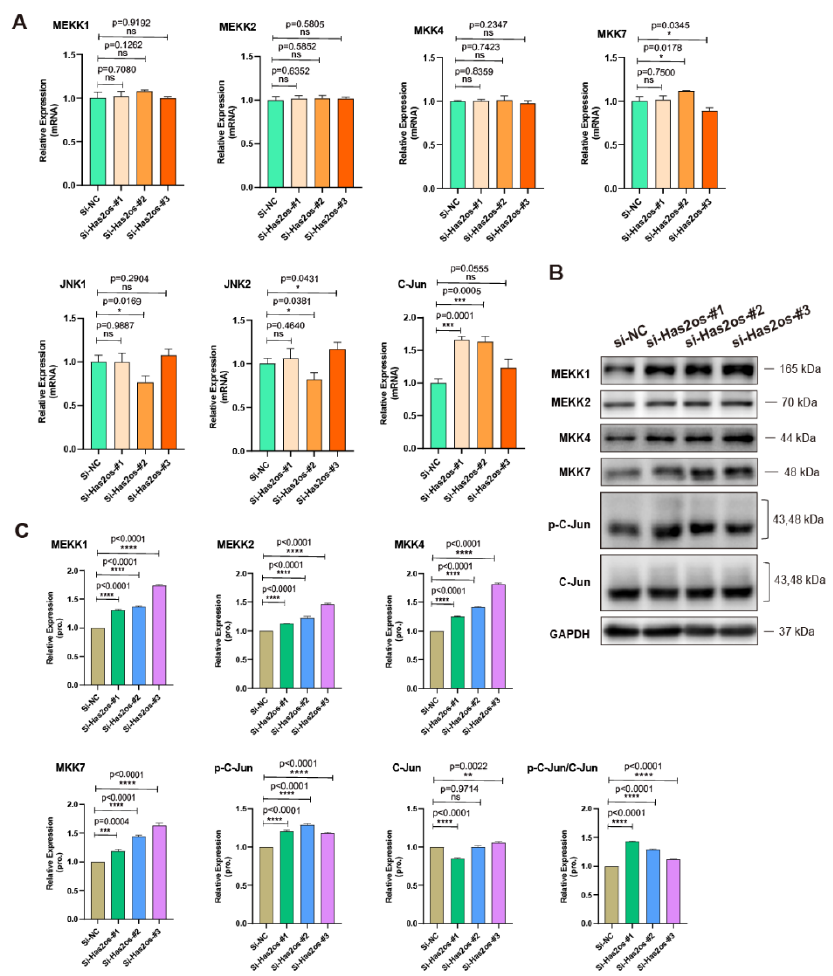
Figure 5. Knockdown of Has2os affected the expression of JNK upstream and downstream factors. Cells Transfected with siRNAs were maintained in growth medium for two days and shifted into DM for another three days, then cells were harvested for analysis. ( A ). qRT-PCR assays of the key factors of the JNK/MAPK signaling (MEKK1, MEKK2, MKK4, MKK7, JNK1, JNK2, and C-JUN) in C2C12 cells that were transfected with si-Has2os or si-NC. The results are normalized to those of with si-NC. ( B ). Western blot analysis shows the protein expression of key factors of JNK/MAPK signaling (MEKK1, MEKK2, MKK4, MKK7, p-C-Jun, and C-Jun). ( C ). Relative expression in ( B ) were calculated. GAPDH was the internal control. The results are normalized to those of with si-NC. Values were presented as means ± SEM. The statistical significance was calculated by t -test.